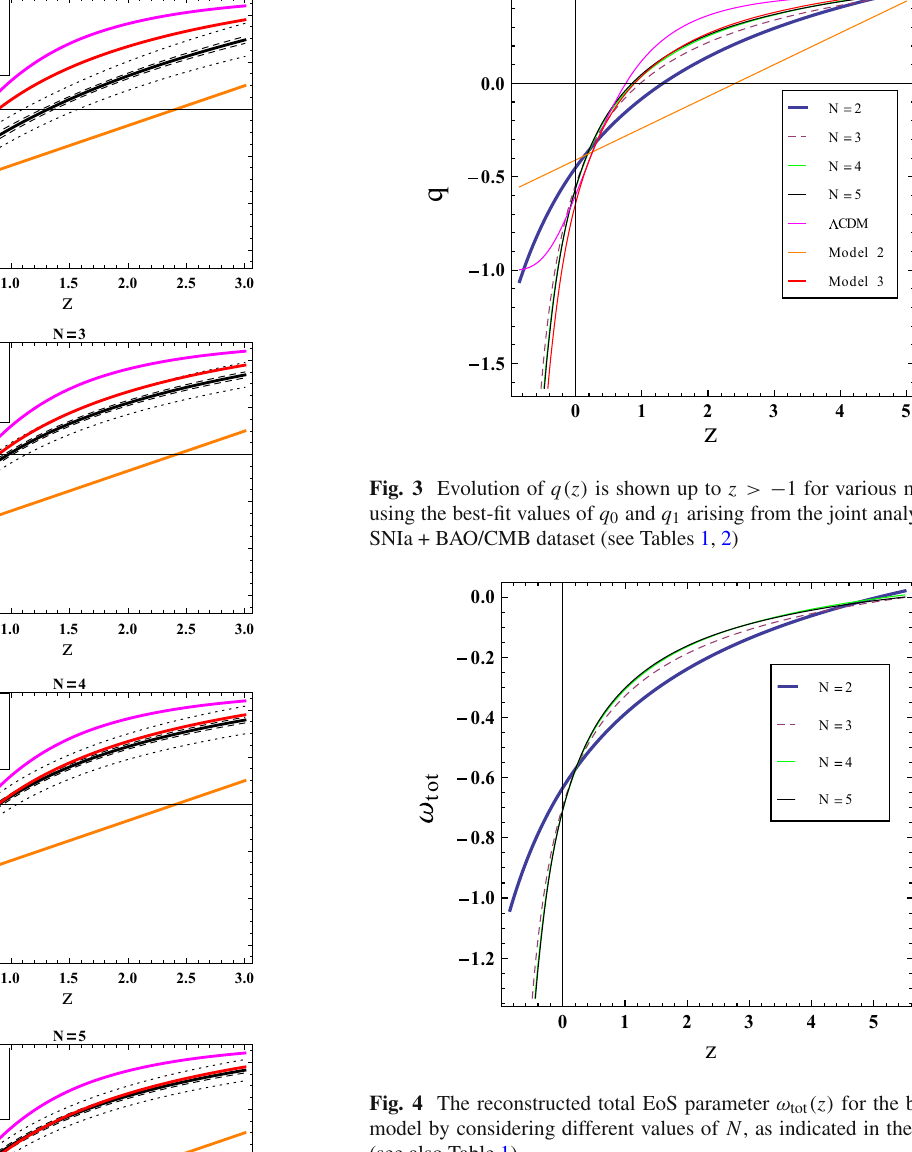
z = 0) for the combined (SNIa + BAO/CMB) dataset.